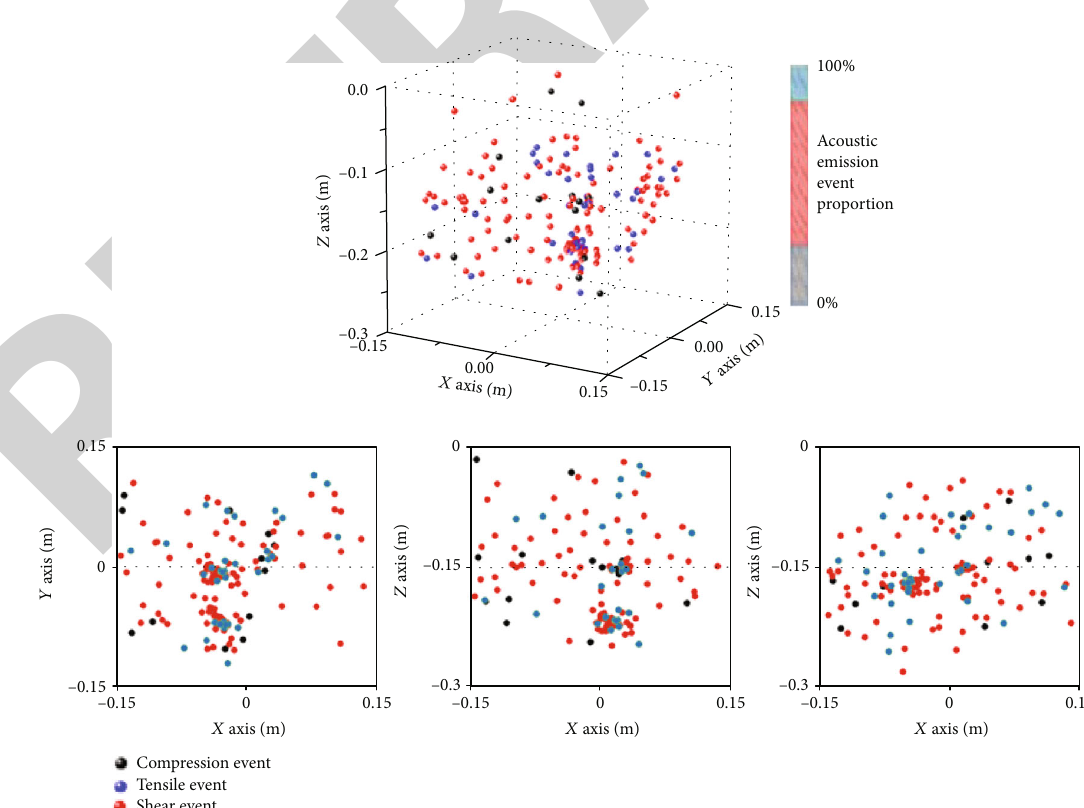
Figure 13: The AE event distribution of Sample 5#.